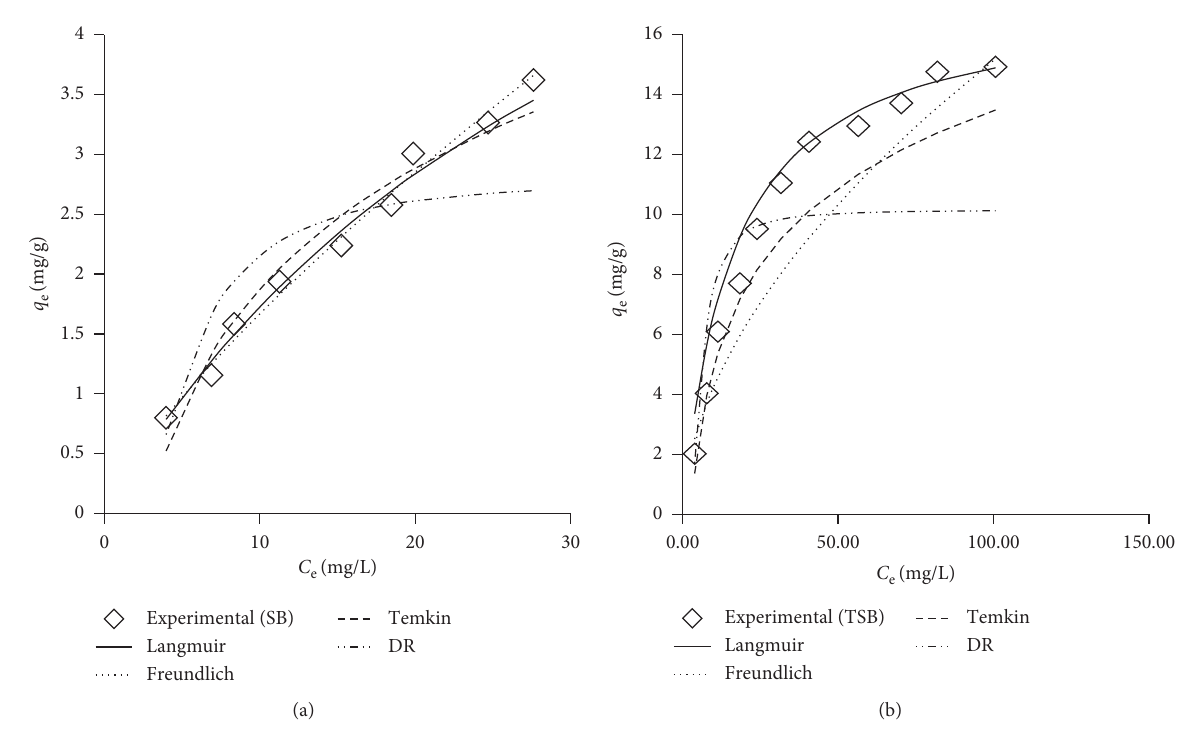
Figure 9: Nonlinear equilibrium plots for Cd(II) biosorption by (a) SB and (b)